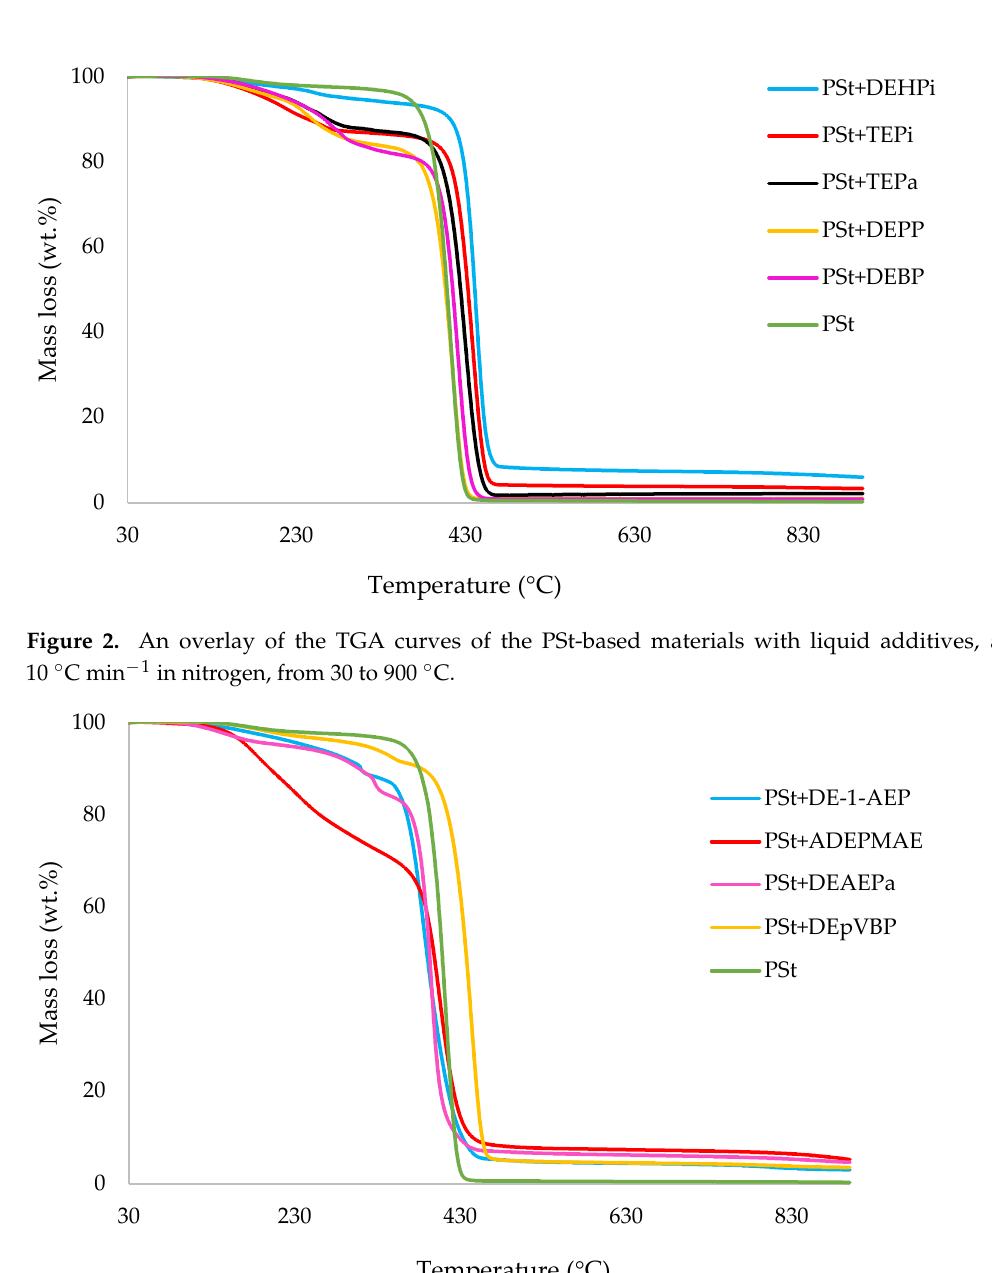
Figure 1. An overlay of the TGA curves of the PSt-based materials with solid additives, at 10 °C min −1 in nitrogen, from 30 to 900 °C.